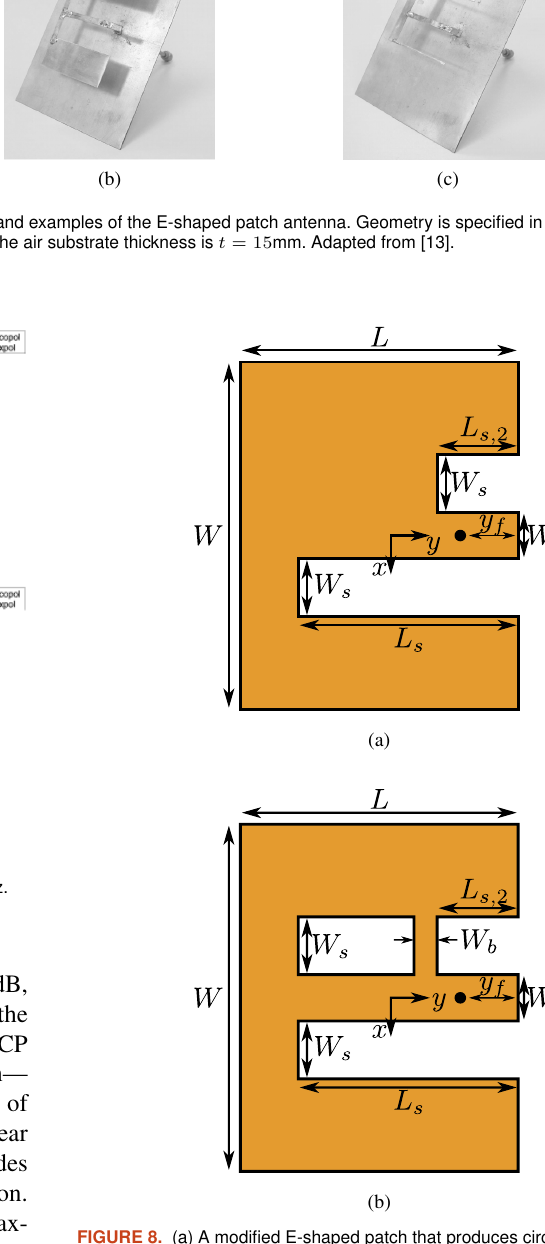
FIGURE 8. (a) A modified E-shaped patch that produces circular polarization (CP) through asymmetric slots [16]. (b) Obtaining CP using a shorting bar across one of the slots [12], [17]. Both versions radiate